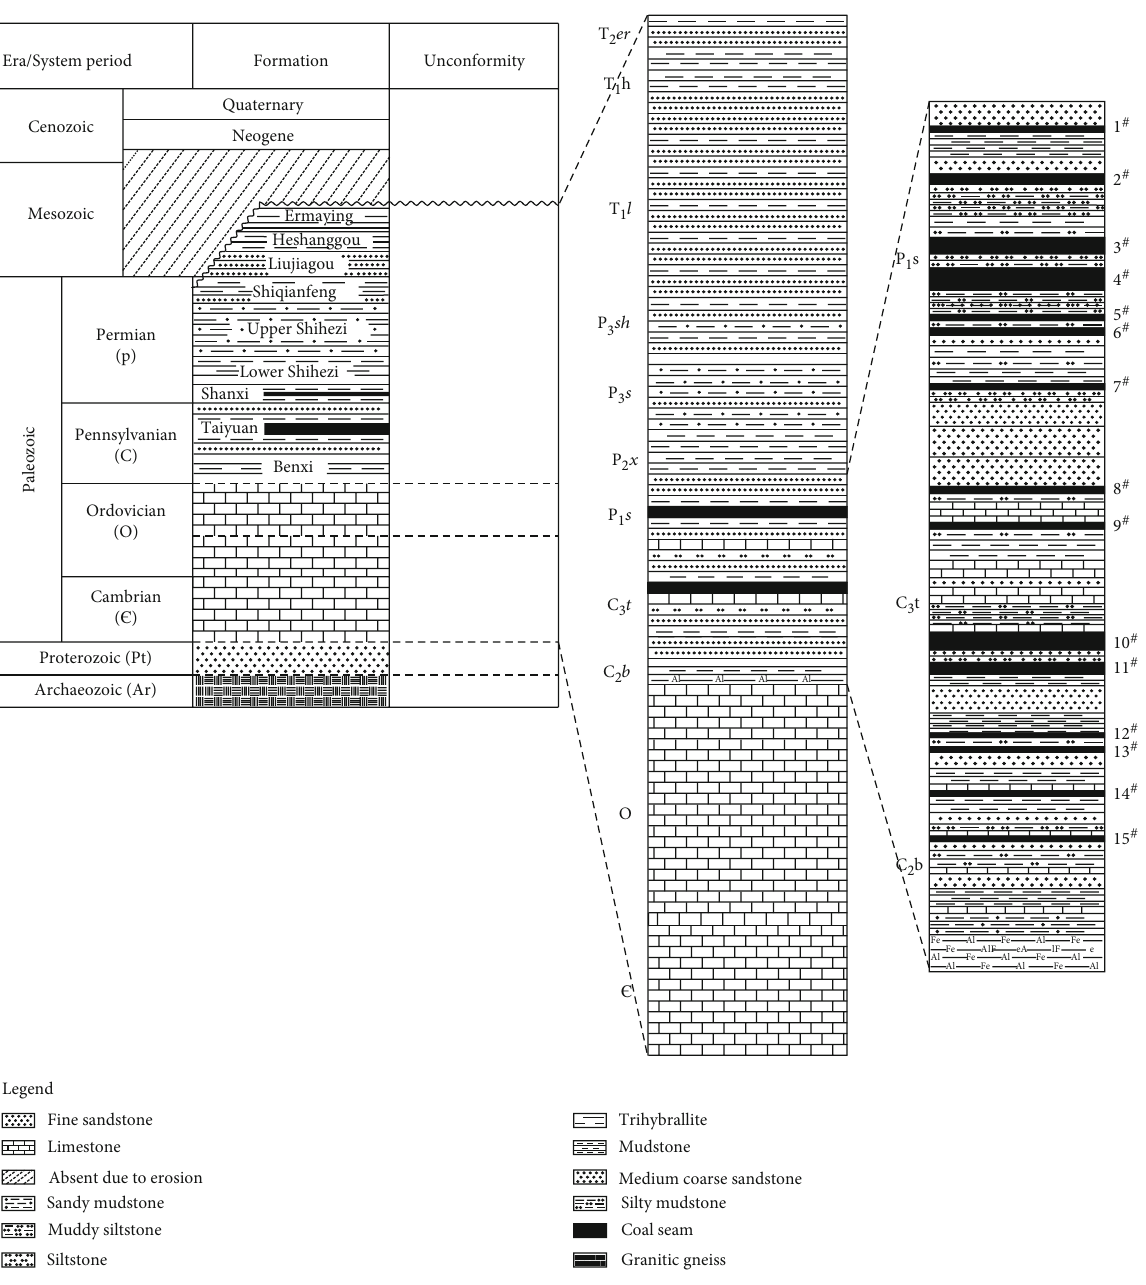
Figure 3: Stratigraphic column of the Gujiao CBM fi eld. The dashed lines indicate the formation unconformity